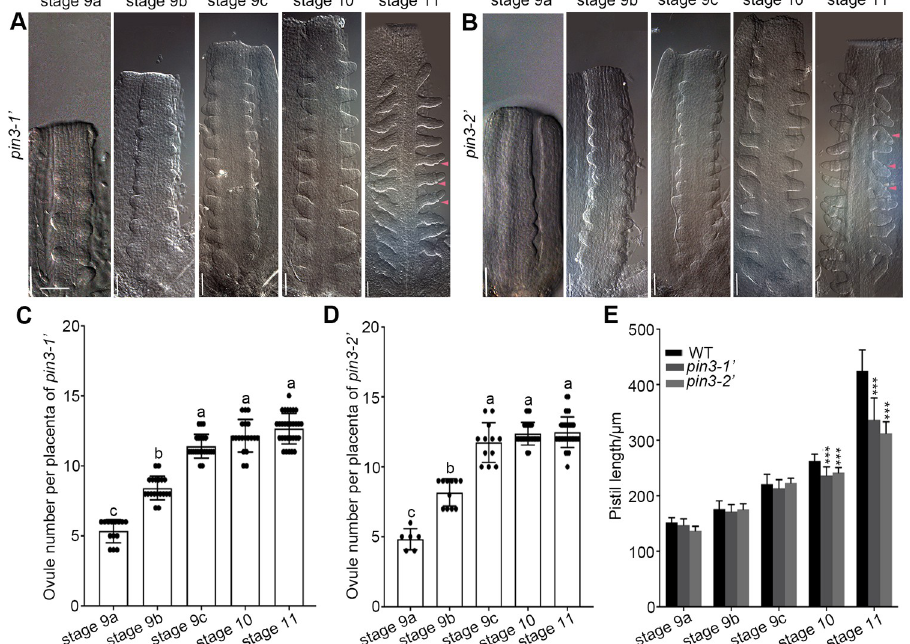
Fig 3. pin3 mutants exhibite defective late ovule initiation. (A-B) Ovule primordia initiation process at floral stages 9a–11 in pin3-1 0 (A) and pin3-2 0 (B) mutants revealed by DIC. Pink arrows indicate the integument primordia. Bars: 20 μ m. (C-D) Ovule number per placenta in pin3-1 0 (C) and pin3-2 0 (D). (E) Pistil length of the wild-type and pin3 mutants. Data are presented as the mean ± SD, n = 15 (C-D) and 10 (E). Significant differences were tested by one-way ANOVA and showed in (C-D, lowercase letters, P < 0.05) and in (E, ��� P <